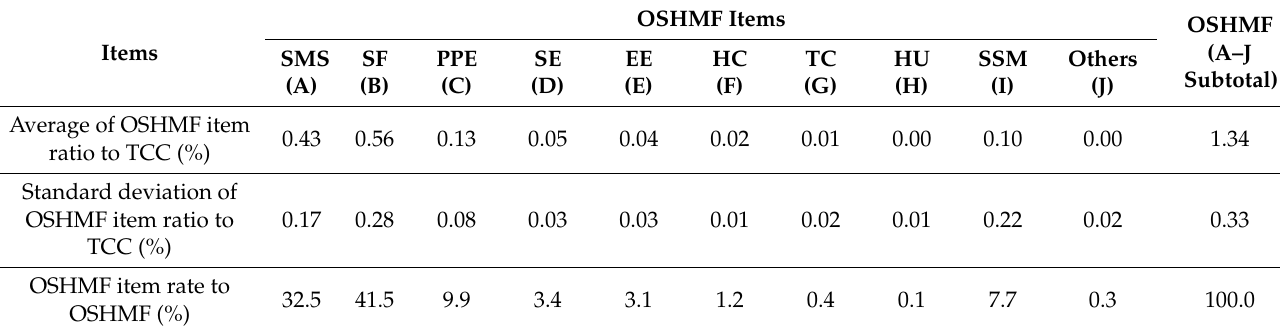
Table 10. Ratio analysis of SME items to TCC.